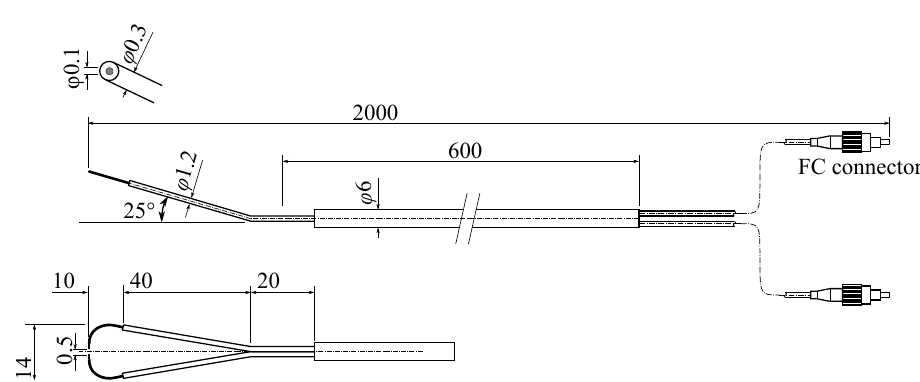
Fig. 7 The optical fiber probe used in the former concentration measurement system (Sakai, et al., 1997). All dimensions are mm.